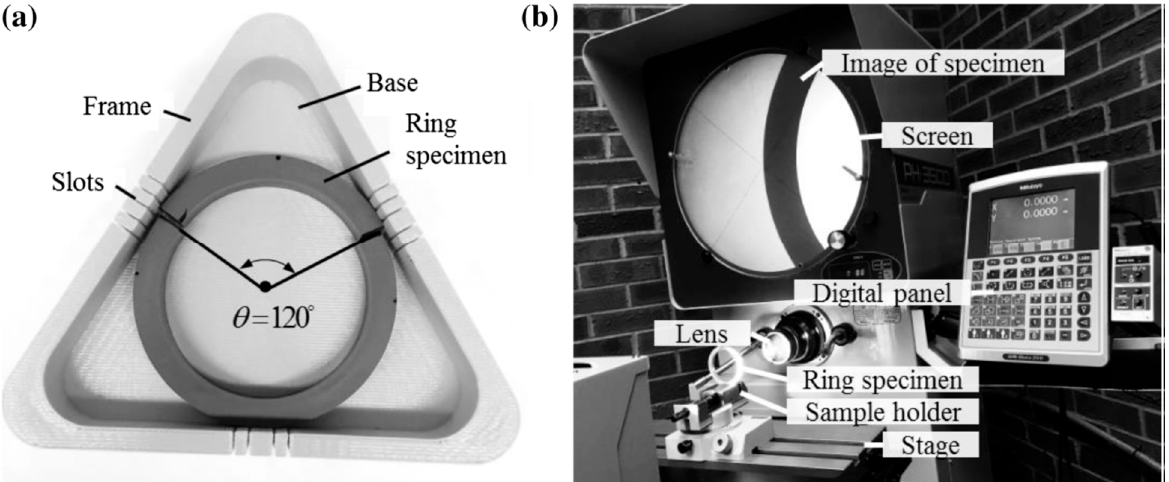
Figure 3. Measurement of the outer diameter change due to the ring slitting: ( a ) a 3D-printed mold for the slitting; and ( b ) the setup of the optical comparator for the measurement of the diameter change. (After Ref. [7], with kind permission from Wiley.)